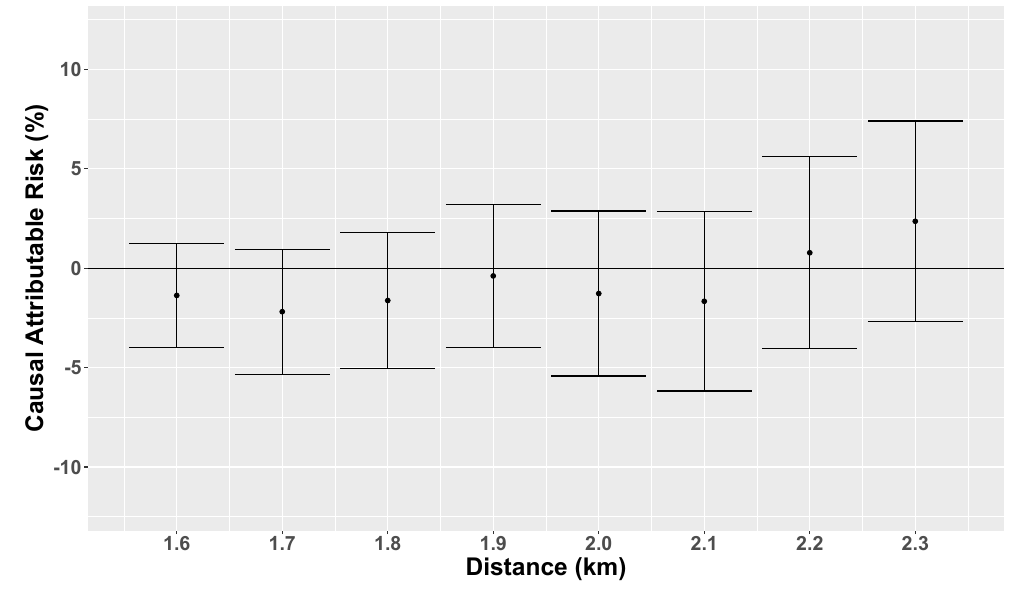
Figure A4. Estimated CAR of asthma in children, expressed as percentage points with whiskers indicate 95% confidence intervals and different distances to the copper mine. Data from children living in a rural mining community in the north of Chile, 2009.